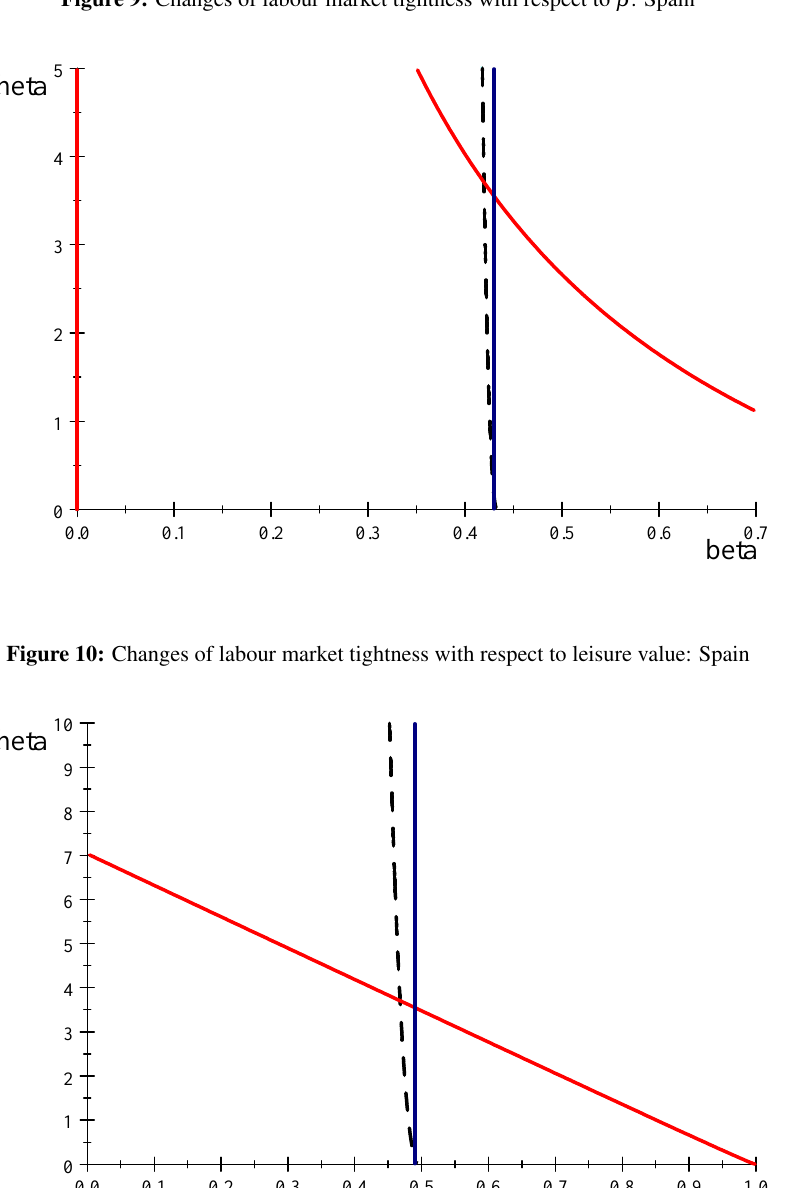
Figure 9: Changes of labour market tightness with respect to β : Spain